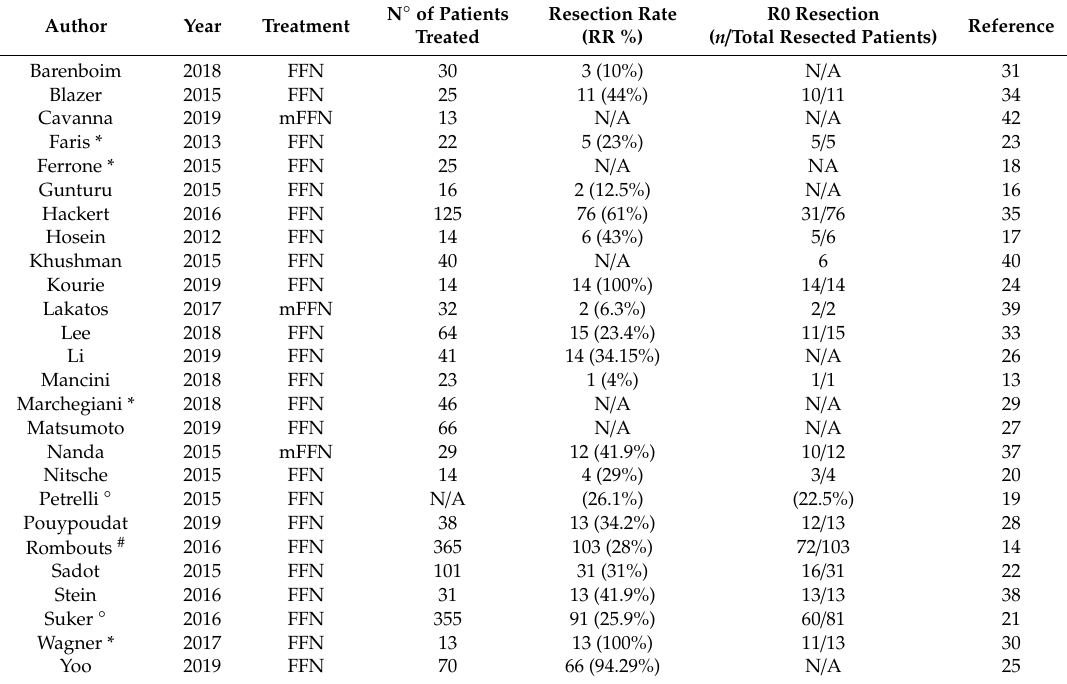
Table 4. Studies evaluating FFN or mFFN included in the systematic